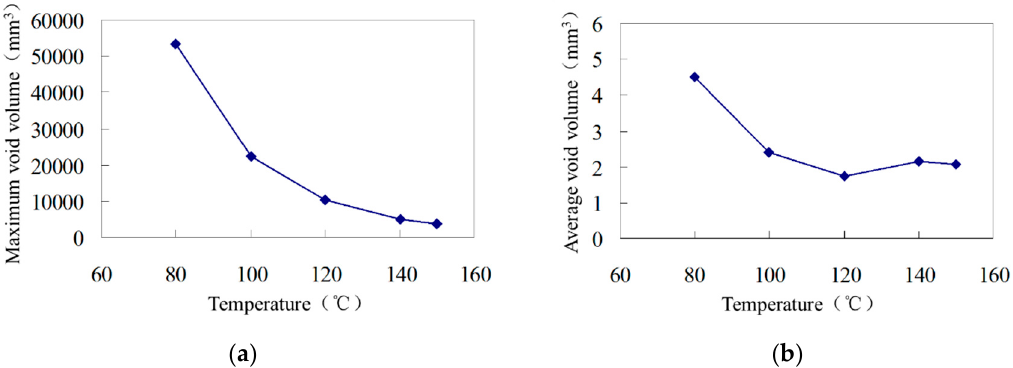
Figure 8. Maximum and average voids of compacted mixtures. ( a ) Maximum void; ( b ) average void.